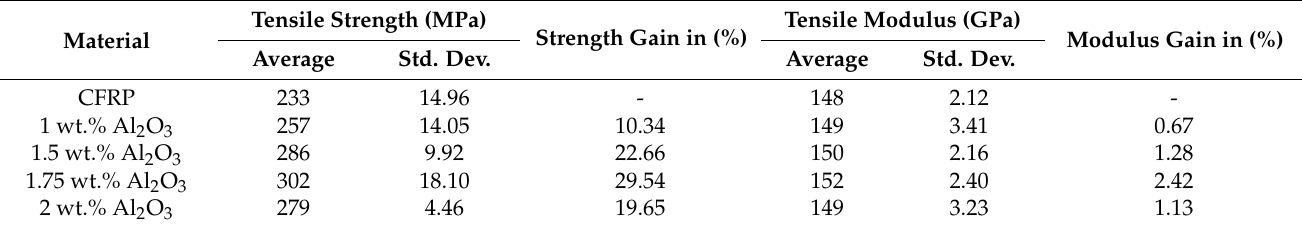
Figure 5. Epoxy resin chain reaction with Al 2 O 3 nano-fillers [52]. Table 3. Tensile behavior of CFRP and hybrid Al 2 O 3 nano-composites.